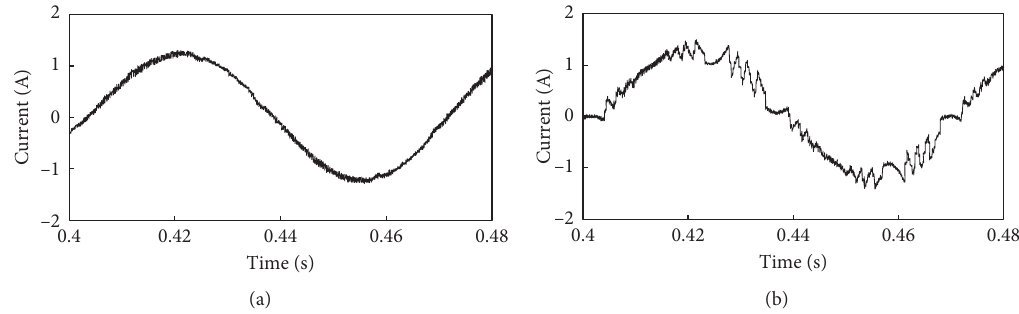
Figure 12: Current output simulation to observe the effect of the flux hysteresis band with (a) 2% and (b) 5% of the flux reference